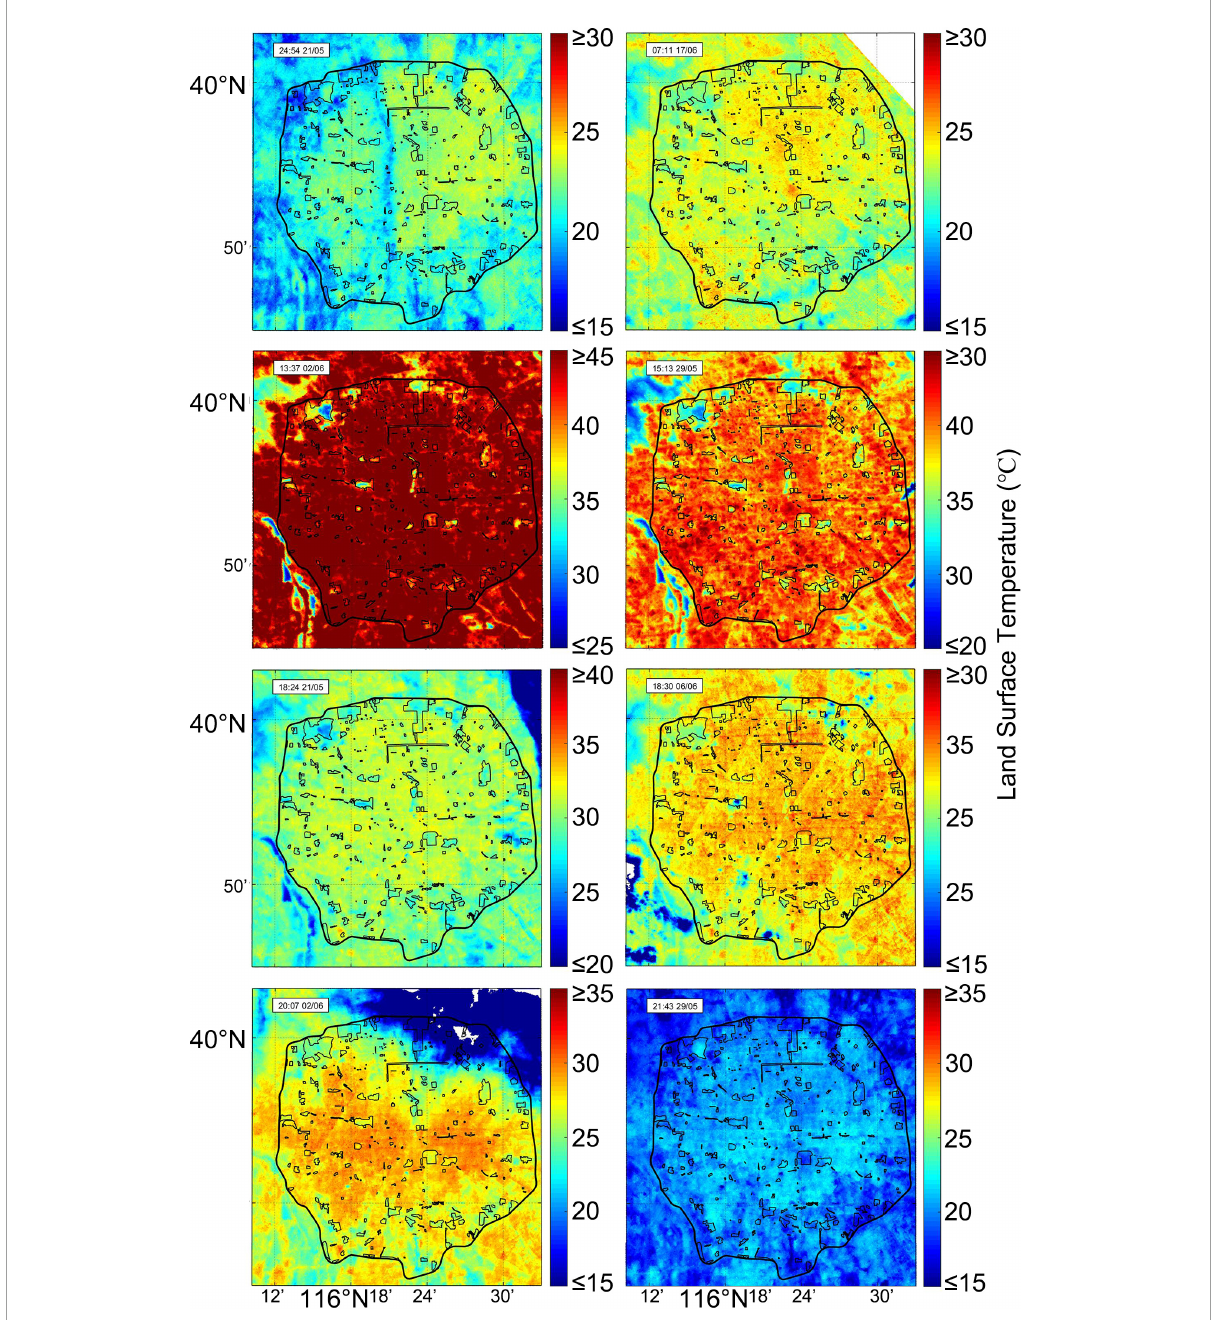
FIGURE3 The distribution of LST at different time in fifth ring, and the measuring time is shown on the left top of each figures. The time is Beijing time (UTC +